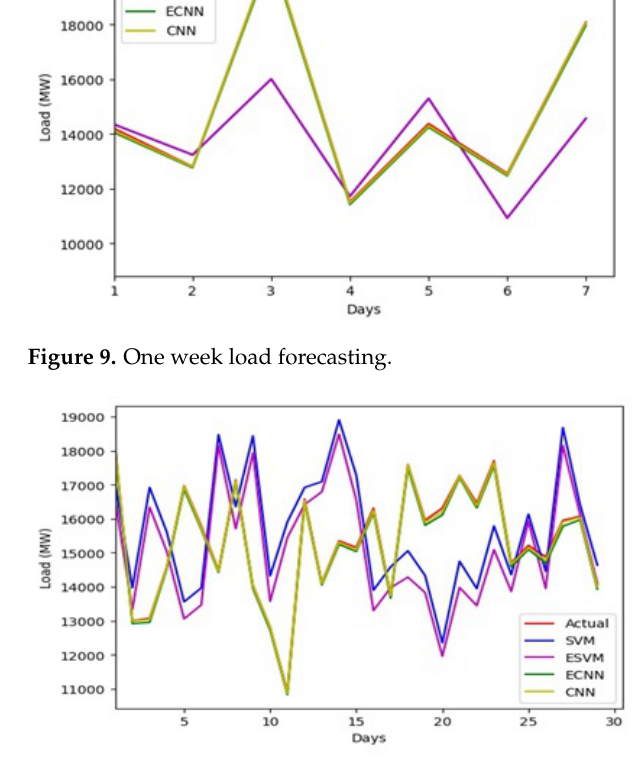
Figure 10. One month load forecasting.